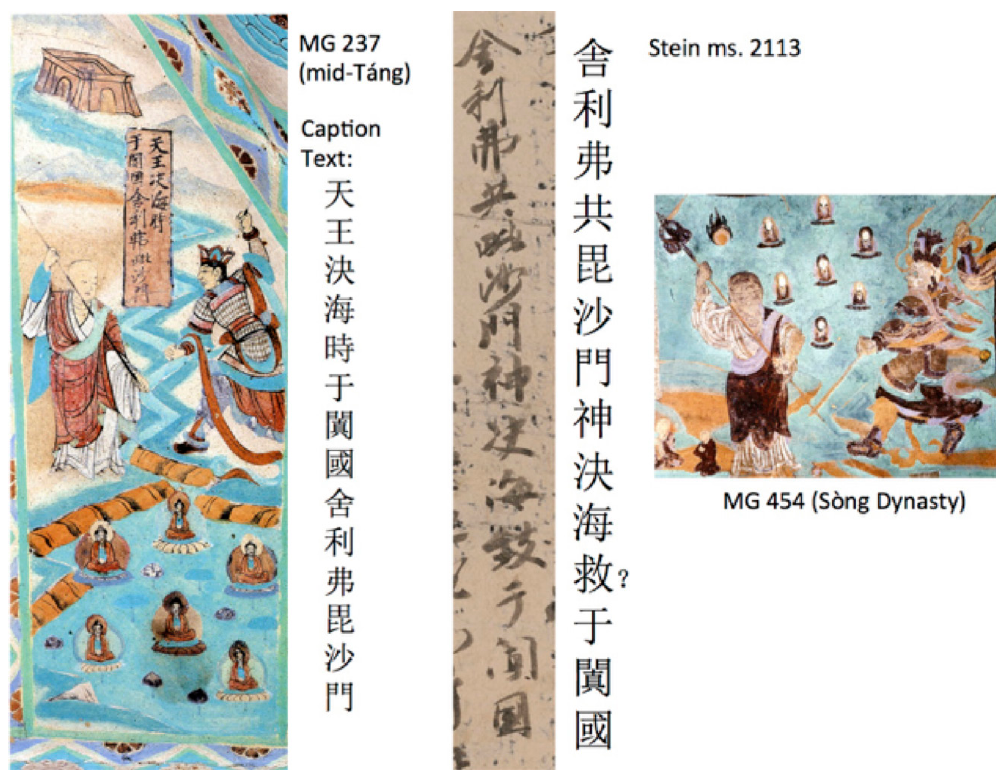
FIgure 7 (left) reproduced from Sūn Xiūshēn 2000, 72, ill. 56. FIgure 8 (middle) passage from Stein 2113. FIgure 9 (right) reproduced from Sūn Xiūshēn 2000, 73, ill. 57. The depiction of the topic is rather standardized, as the comparison between the illustrations in D-MG 237 from the mid-Táng (left), and D-MG 454 from the Sòng period (right) show. D-MG 237 also includes a caption text: ‘The scene of heavenly kings draining the ocean.’ Ms. Stein 2113 (middle) has the following entry: ‘Sāriputra and the deity Vaiśravaṇa draining the ocean and saving